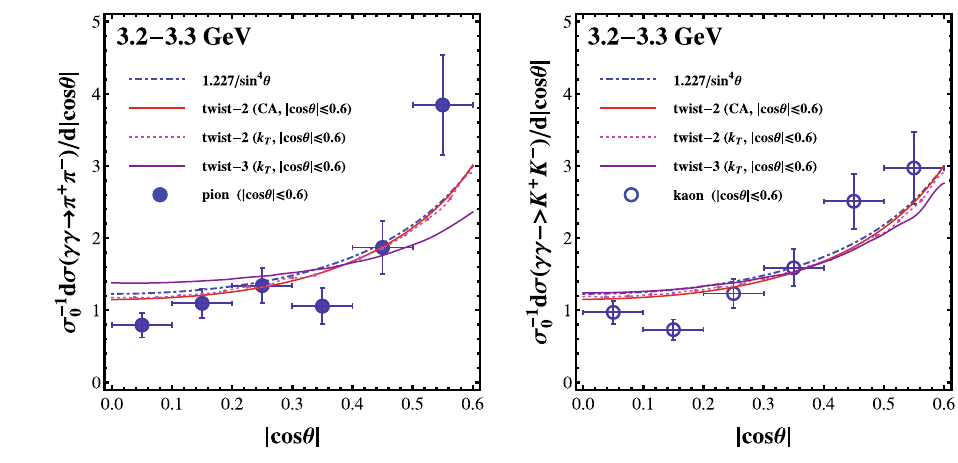
Fig. 7 Angular distributions σ − 1 d σ/ d | cos θ | for the 0 processes γγ → M + M − . Red solid line: the twist-2 results in the collinear factorization; Magenta dashed line: the twist-2 results in the k T factorization; Purple solid lines: the twist-3 results in the k T factorization. All the nonperturbative input parameters are chosen at their central values. The experimental points are from Ref.